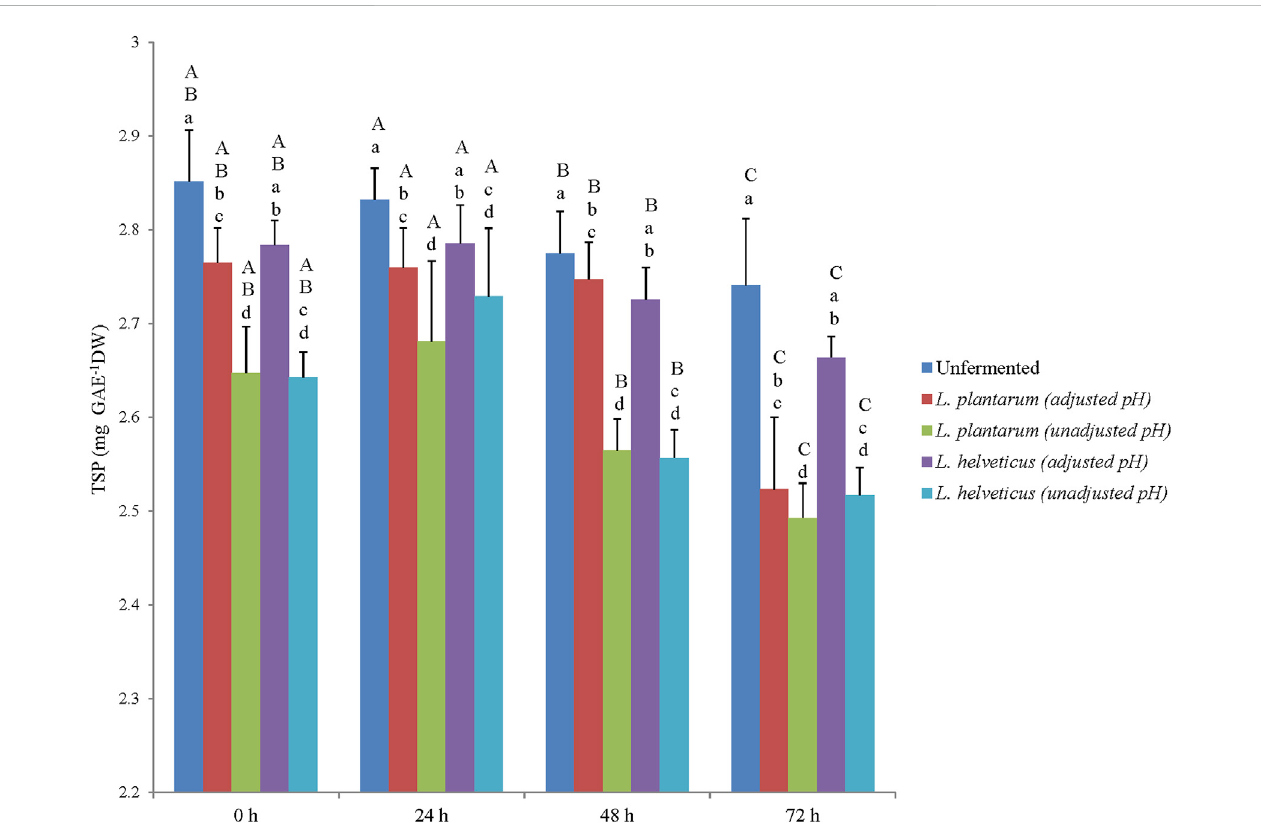
FIGURE 1 Total soluble phenolic content (mg GAE g − 1 ) of the unfermented and fermented corn DDGS extracts. Different lowercase letters represent statistical differences in TSP content among the extracts ( p < .05). Different uppercase letters represent statistical differences in TSP content among the fermentation time points ( p <